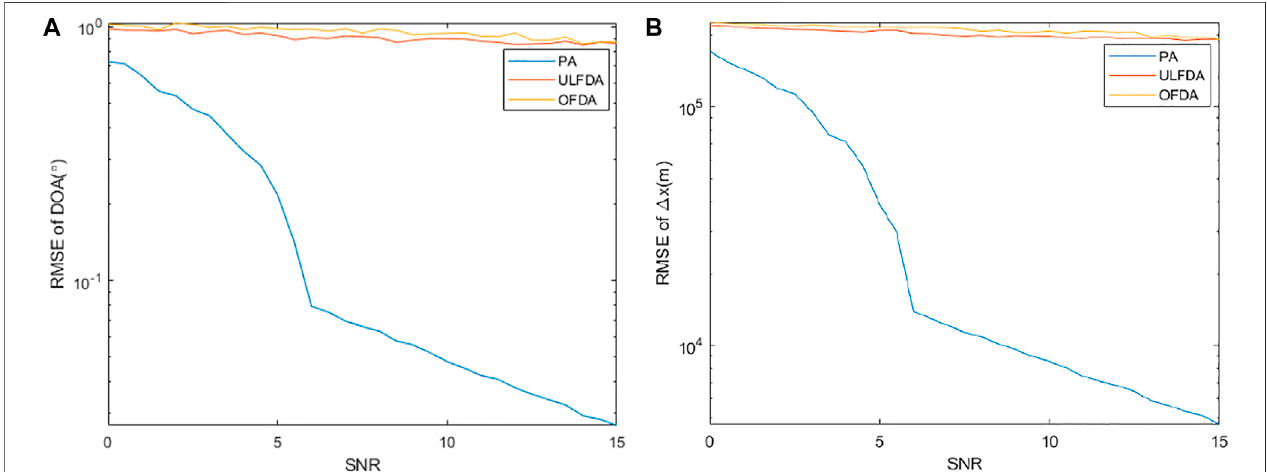
FIGURE 8 | The variation of deception effect with SNR (A) RMSE of DOA (B) RMSE of location.